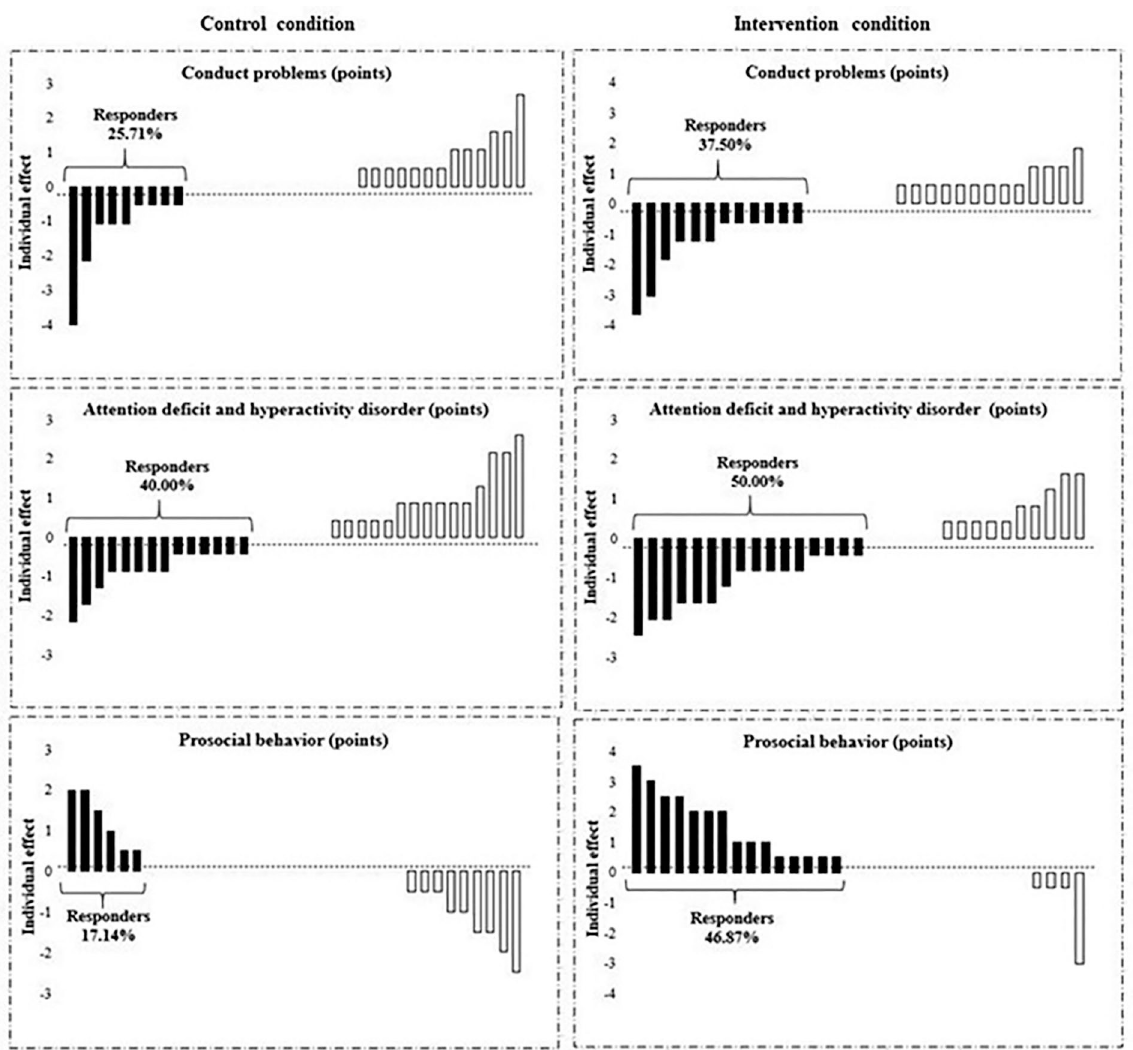
Figure 4 - Prevalence of responders in intervention and control conditions after physical education programs at school in